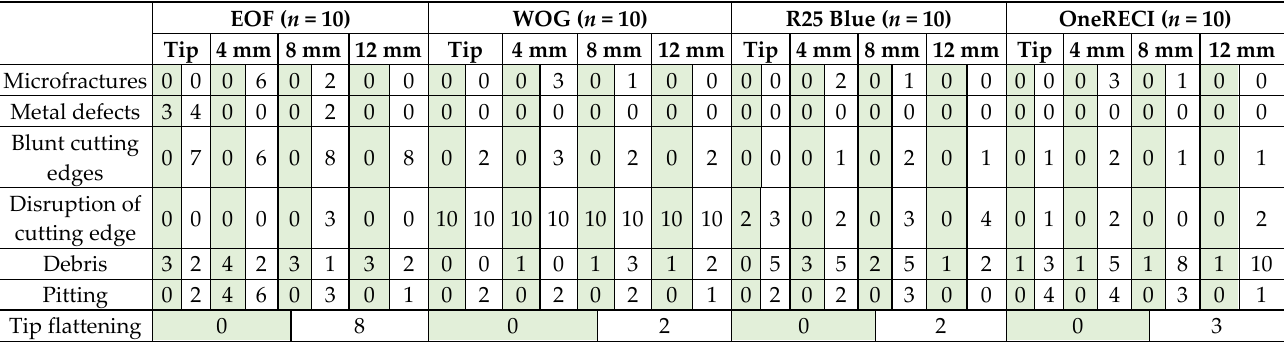
Table 1. Schematic representation of the incidence of pre-operative (green cells) and post-operative (white cells) surface defects in relation to the selected instruments. EOF (EdgeOne Fire), WOG (WaveOne Gold), R25 Blue (Reciproc Blue).